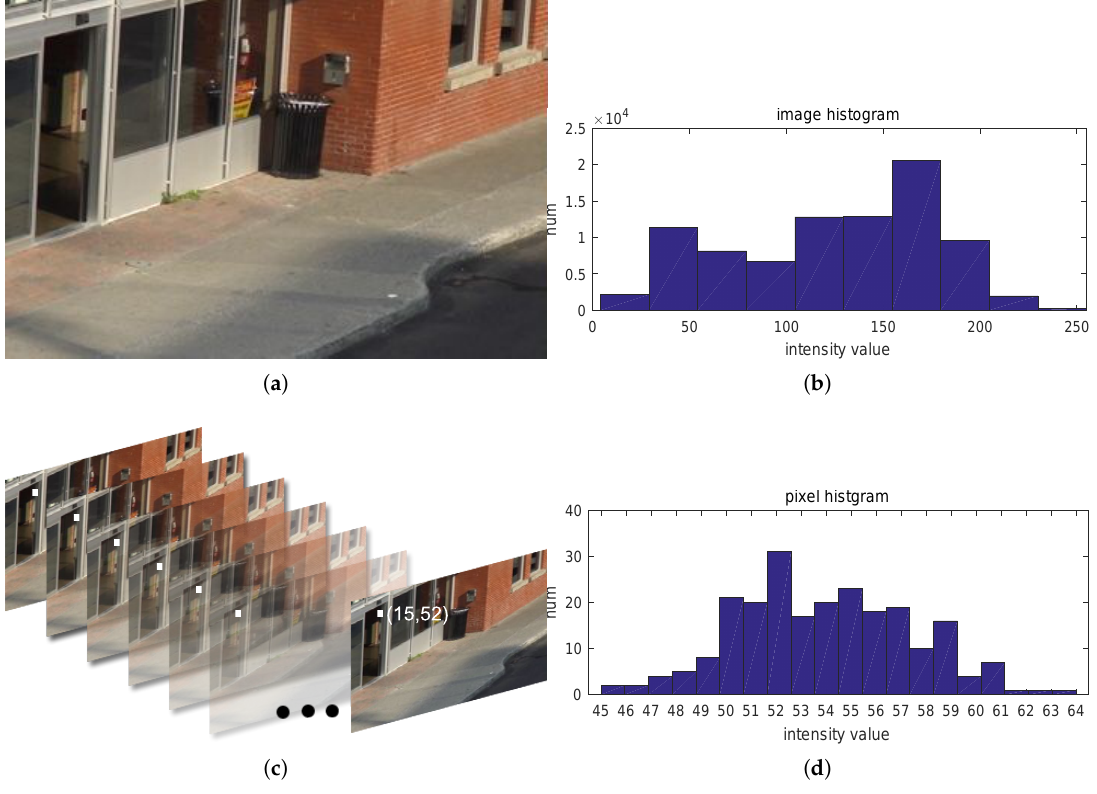
Figure 4. ( a , c ) display one image and an image sequence of the training set of the scene bus station in category shadow ; ( b , d ) exhibit their histograms: image histogram and pixel histogram. Not like the image histogram, the range of pixel histogram always concentrates on a small interval, for instance from 45–64 in pixel (15,